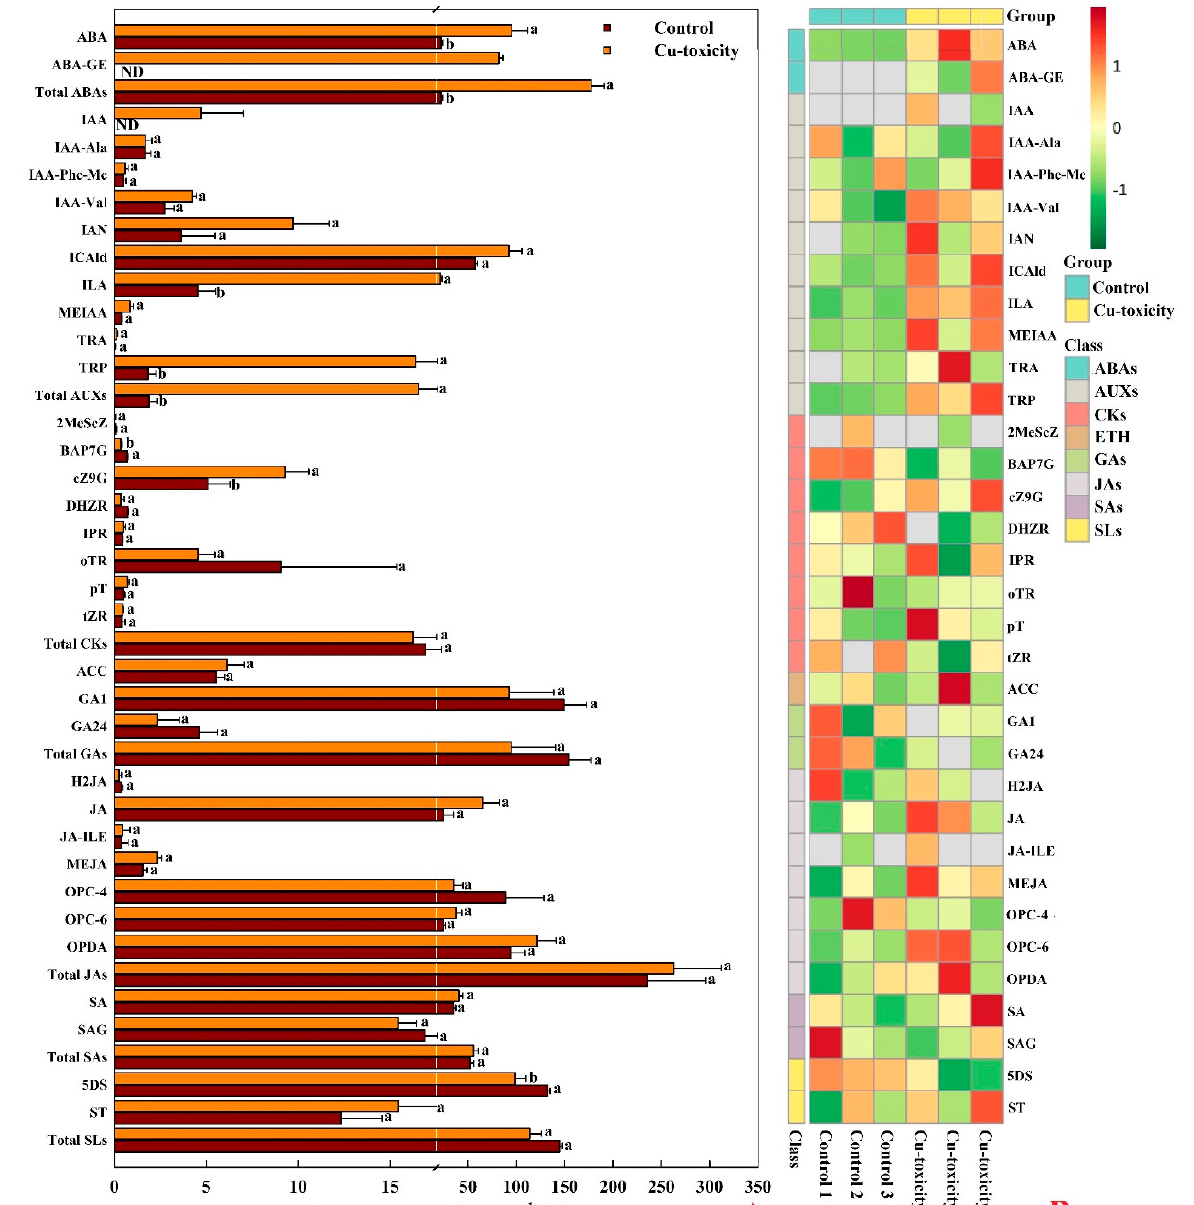
Figure 5. Cu-toxic effects on mean ( ± SE, n = 3) concentrations of hormones in leaves ( A ) and Heatmap of 34 hormones identified in leaves of C. grandis seedlings with 0.5 (control) and 400 (Cu-toxicity) µ M Cu ( B ). Total ABAs, AUXs, CKs, GAs, JAs, SAs and SLs were the summation of all individual hormone detected for each class. Units for TRP and total AUXs were µ g g − 1 FW. For the same hormone, different letters above the bars indicate a significant difference at p < 0.05. ABA-GE, ABA-glucosyl ester; ACC, 1-aminocyclopropanecarboxylic acid; AUXs, auxins; BAP7G, N6-benzyladenine-7-glucoside; CKs, cytokinins; cZ9G, cis-zeatin-9-glucoside; DHZR, dihydrozeatin ribonucleoside; 5DS, 5-deoxystrigol; ETH, ethylene; GA1, gibberellin A1; GA24, gibberellin A24; GAs, gibberellins; H2JA, dihydrojasmonic acid; IAA, indole-3-acetic acid; IAA-Ala, N -(3-indolylacetyl)- L -alanine; IAA-Phe-Me, indole-3-acetyl- L -phenylalanne methyl ester; IAA-Val, N -(3-indolylacetyl)- L - valine; IAN, 3-indoleacetonitrile; ICAld, indole-3-carboxaldehyde; ILA, indole-3-lactic acid; IPR, N6-isopentenyladenosine; JA, jasmonic acid; JA-ILE, jasmonoyl- L-isoleucine; JAs, jasmonates; MEIAA, methyl indole-3-acetate; MEJA, methyl jasmonate; 2MeScZ, 2-methylthio-cis-zeatin; OPC-4, 3-oxo-2-(2-(Z)-pentenyl) cyclopentane-1-butyric acid; OPC-6, 3-oxo-2-(2-(Z)-pentenyl)cyclopentane-1-hexanoic acid; OPDA, cis(+)-12-oxophytodienoic acid, oTR, ortho-topolin riboside; pT, para-topolin; SA, salicylic acid; SAG, salicylic acid 2-O- β -glucoside; SAs, salicylates; SLs, strigolactones; ST, ( ± ) strigol; TRA, tryptamine; TRP, L -tryptophan; tZR, trans-zeatin